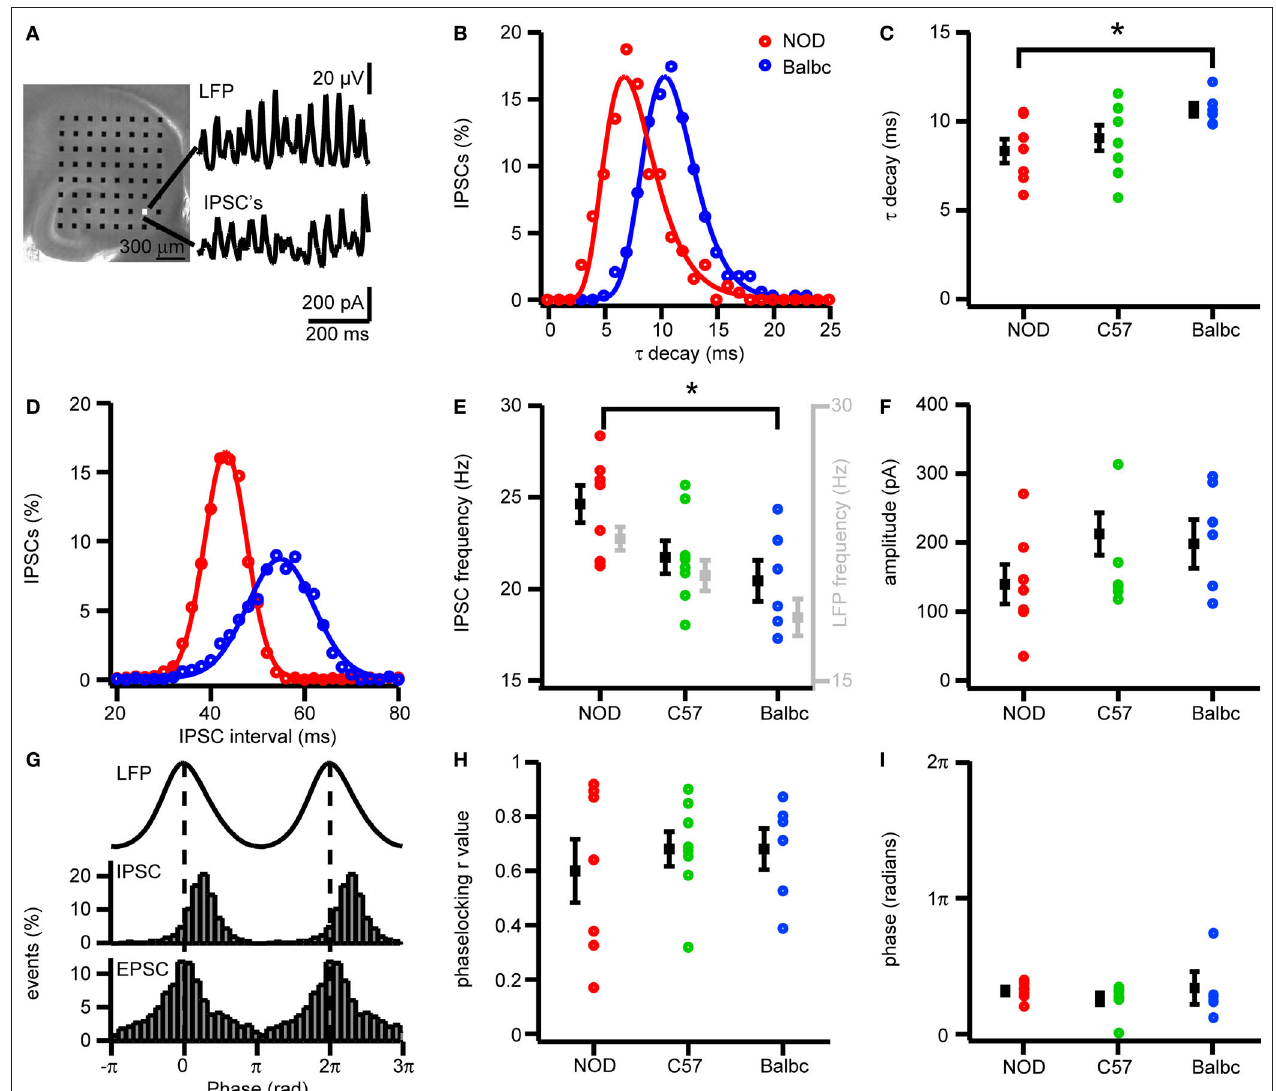
FiGuRe 3 | iPSCs in CA3 pyramidal cells of NOD and Balbc mice differ in iPSC frequency and τ decay times. (A) Hippocampal slice placed on a 64 electrode grid and example traces of local field potential and corresponding IPSCs in a CA3 pyramidal cell from an NOD mouse. (B) Histogram of decay time constants of IPSCs from NOD (red) and Balbc (blue) mice. Histograms are fitted with lognormal functions. (C) Decay time constants of NOD ( n = 7), C57 ( n = 8) and Balbc ( n = 6) mice. NOD mice have faster decay time constants than Balbc mice ( p < 0.05). Average values are shown in black. (D) Histogram of IPSC interval times from cells of NOD and Balbc mice. Histograms are fitted with a Gaussian function. The average IPSC frequency is calculated as 1/average interval